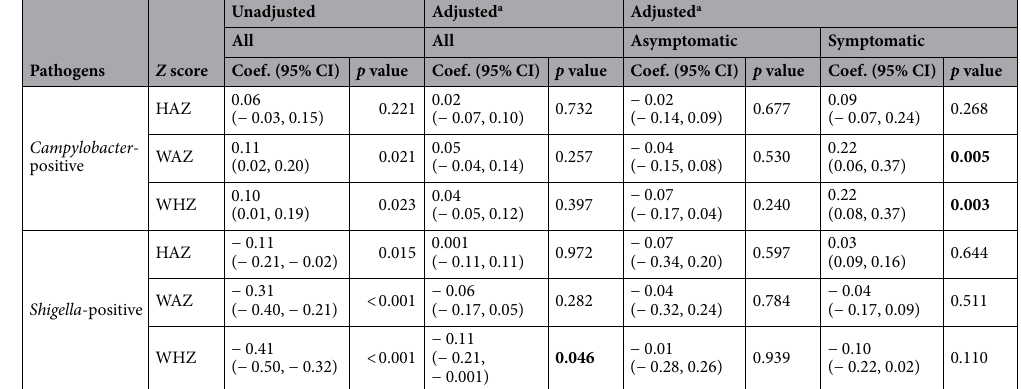
Table 3. Association of fecal Shigella and Campylobacter with a child’s HAZ, WAZ, and WHZ: results of generalized estimating equations modeling (dependent variable—HAZ, WAZ, and WHZ). Coef., coefficient; CI, confidence interval; HAZ, height-for-age z score; WAZ, weight-for-age z score; and WHZ, weight-for- height z score. a Adjusted for age, gender, MSD, breastfeeding status, mother’s education, number of people regularly sleep in the house, number of under-5 children at house, hand washing before nursing a child and after cleaning the child, handwashing material, main source of drinking water, available toilet facility, wealth index, copathogen: Cryptosporidium and Giardia , and comorbidity (malaria, typhoid, pneumonia, diarrhea, and dysentery).